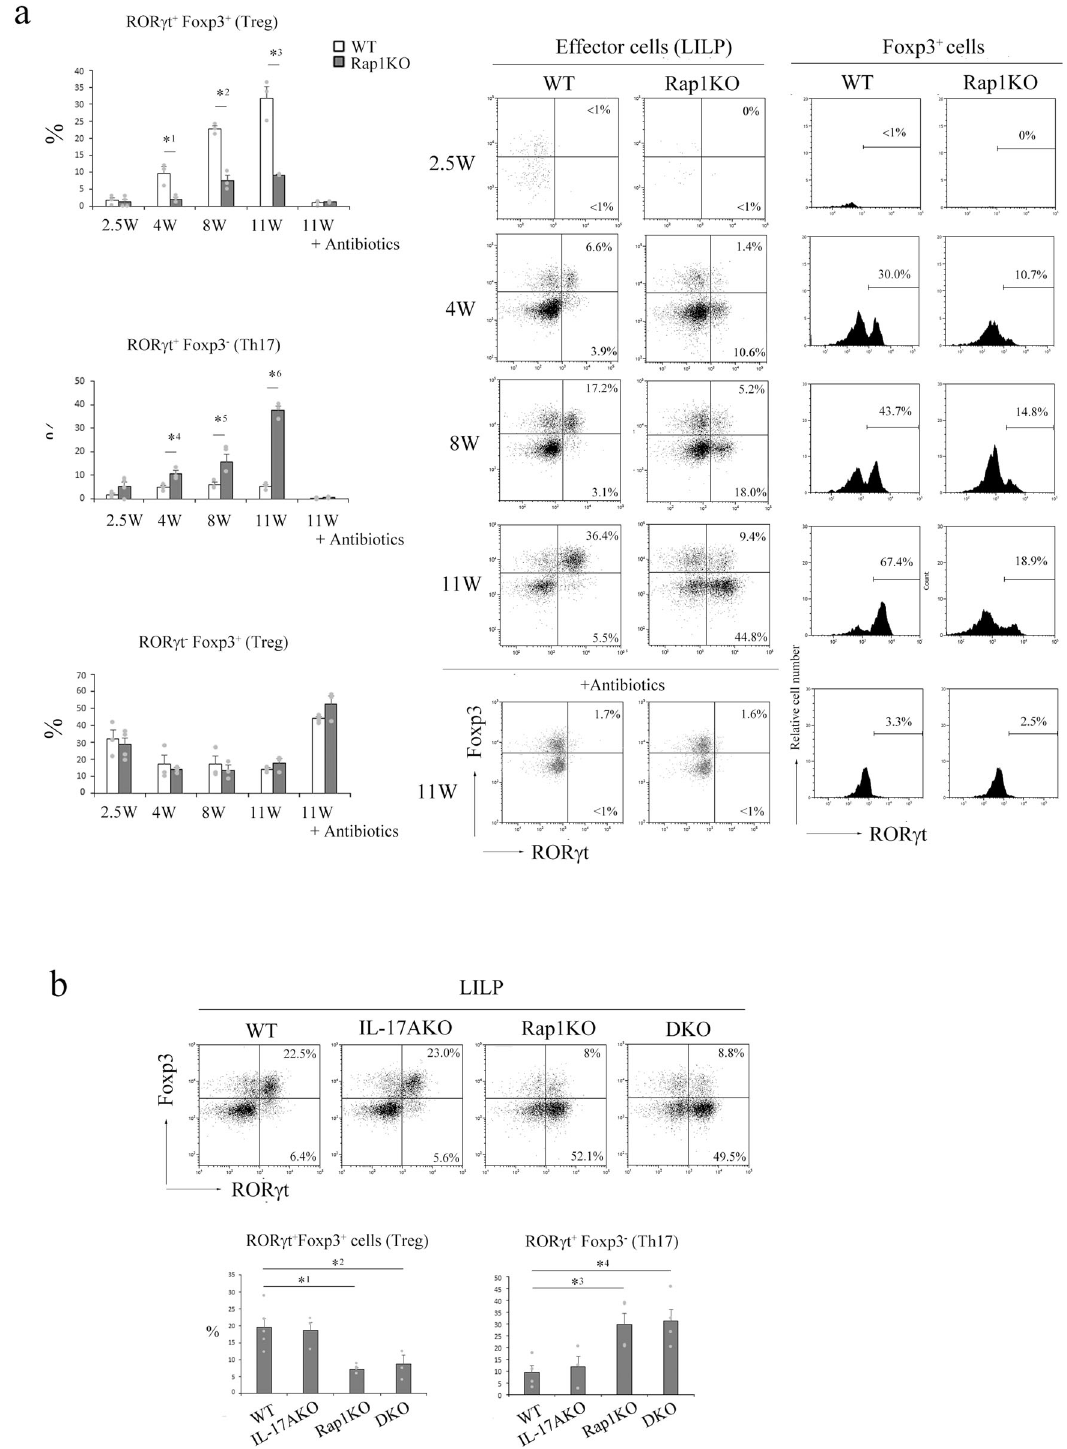
Fig. 2 The percentages of ROR γ t + Treg cells decreased in the LILP of Rap1KO mice. a (Left) The percentages of ROR γ t + Foxp3 + cells (top), ROR γ t + Foxp3 − cells (middle), and ROR γ t − Foxp3 + cells (bottom) to effector CD4 + cells in the LILP of WT and Rap1KO mice with or without the administration of antibiotics at 2.5 – 11 weeks of age ( n = 3 – 4). Data represent the mean±S.E.M. * 1 P <0.02, * 2 P <0.001, * 3 P <0.003, * 4 P <0.03, * 5 P <0.03, and * 6 P <0.001 compared with the corresponding WT mice. (Right) Representative ROR γ t and Foxp3 pro fi les of effector CD4 + cells (left) and ROR γ t histogram pro fi les of Foxp3 + cells (right) from the LILP of WT and Rap1KO mice at the indicated age (weeks). b (Upper) Representative ROR γ t and Foxp3 pro fi les of effector CD4 + cells from the LILP of WT, IL-17AKO, Rap1KO, and DKO mice at 8 – 12 weeks of age. (Lower) The percentages of ROR γ t + Foxp3 + cells (left) and ROR γ t + Foxp3 − cells (right) to CD4 + cells derived from the LILP of WT, IL-17AKO, Rap1KO, and DKO mice at 8 – 12 weeks of age ( n = 3 – 5). Data represent the mean±S.E.M. * 1 P <0.005, * 2 P <0.03, * 3 P <0.02 and * 4 P <0.02 compared with the corresponding WT mice.